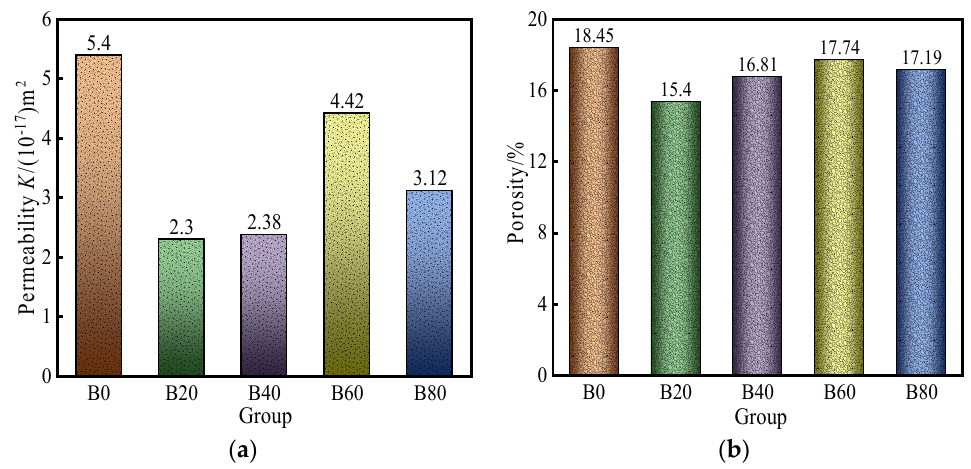
Figure 4. Initial gas permeability and porosity measured: ( a ) gas permeability, ( b ) porosity measured.